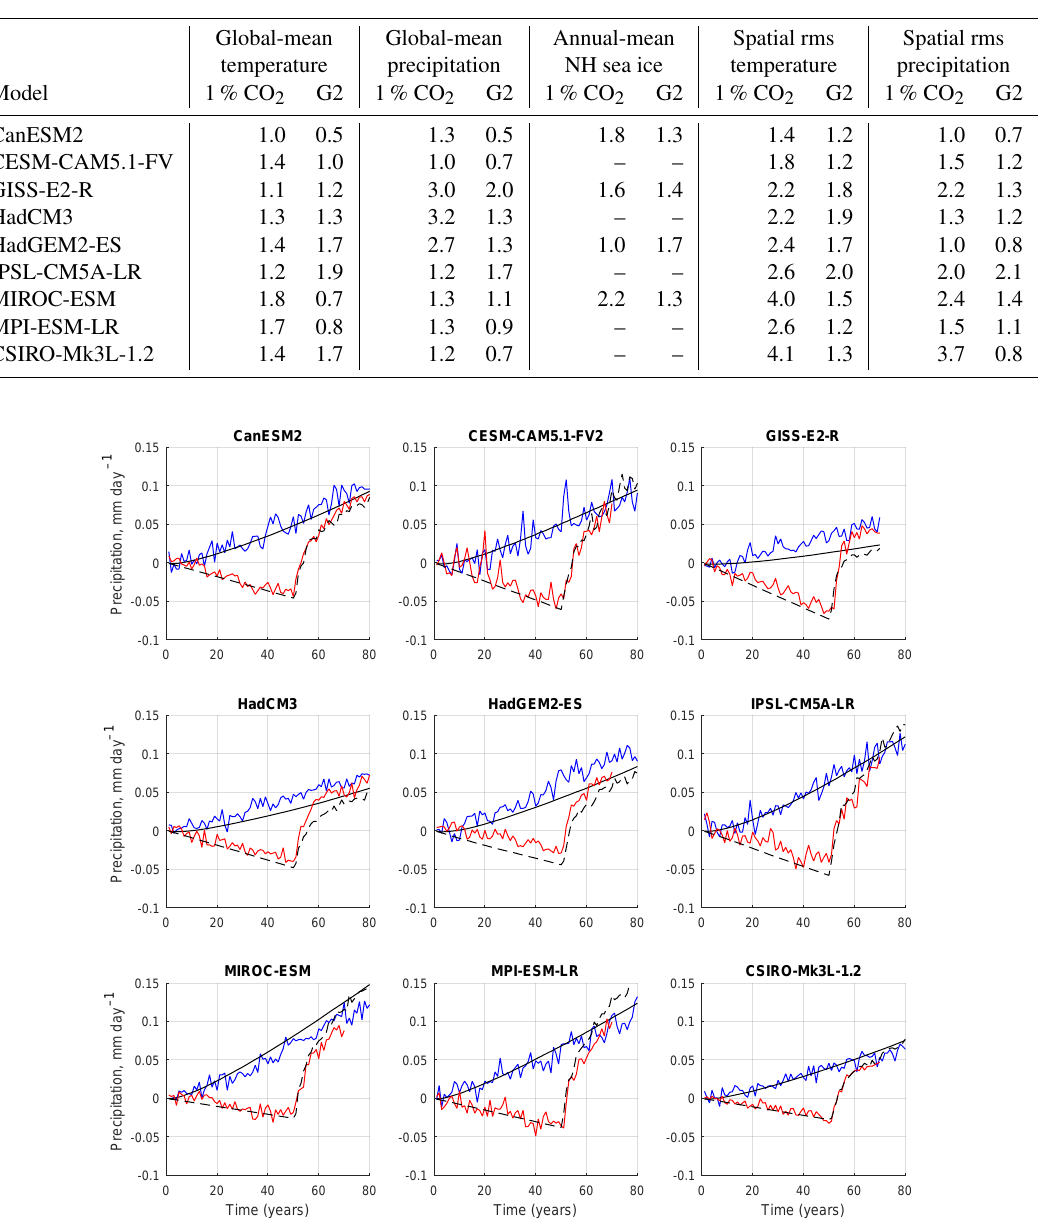
Table 1. Root mean square (rms) deviation between simulation and emulator prediction. For the first three (scalar) variables, temporal rms is computed over years 31–50, normalized by the standard deviation of interannual natural variability. For the spatial response, the area- weighted rms is computed after normalizing by variability at each grid cell (i.e., the spatial rms of the deviation as measured in standard deviations of natural variability).